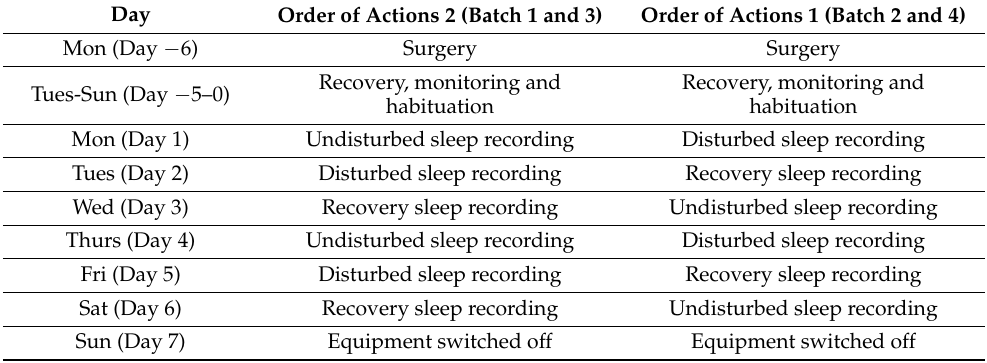
Table 2. Experiment diary.